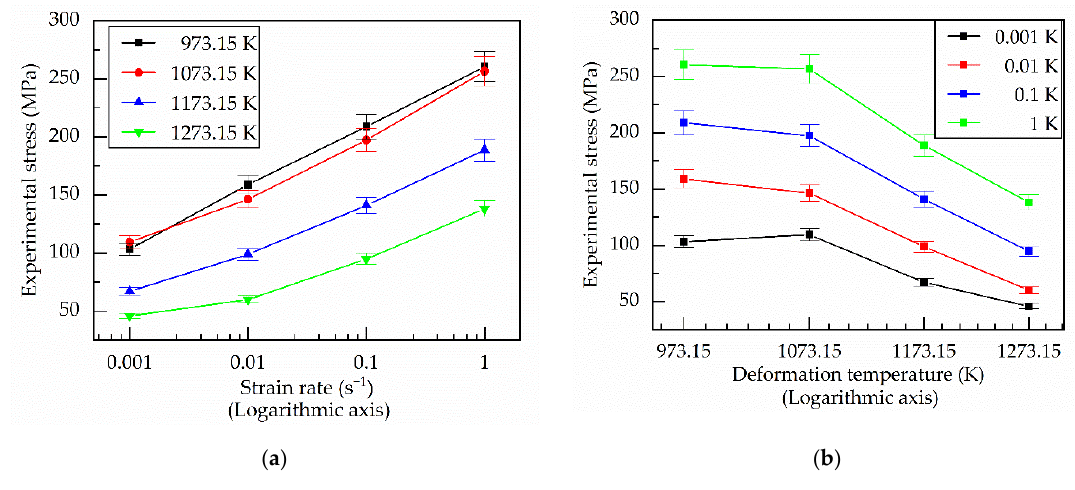
Figure 3. Relationship between stress and ( a ) strain rate; ( b ) deformation temperature under the strain of 0.30.